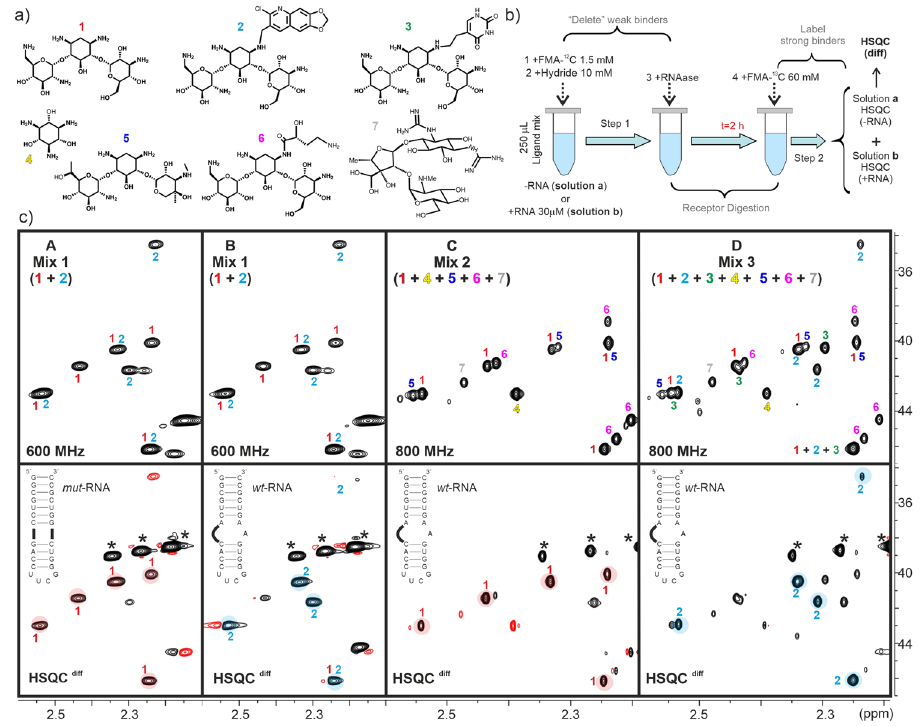
Fig. 5 Protection assays with aminoglycoside mixtures. a RNA ligands employed for the different assays. b Schematic representation of the reactivity- based screening protocol (protocol 2). Ligand mixtures of increasing complexity, both in the absence or presence of 30 μ M receptor ( – RNA and + RNA samples, respectively), were treated with 1 mM unlabelled formaldehyde under reductive amination conditions. After RNA digestion, the reaction is completed with an excess of labelled reagent. The resulting mixtures of per- N -methyl-ligands were analysed by means of HSQC experiments at pH 10 (neutral species). In order to highlight differences in cross-peak intensity between the HSQC + RNA and HSQC − RNA data sets, they were subtracted to provide an HSQC diff spectrum. c HSQC − RNA (top) and HSQC diff (bottom) data sets obtained after applying our protocol to ligand mixtures 1 - 3 (from left to right). The RNA receptor employed in every case is shown. Cross-peaks for every mixture component are labelled. HSQC diff spectra (bottom) allow the identi fi cation of the best